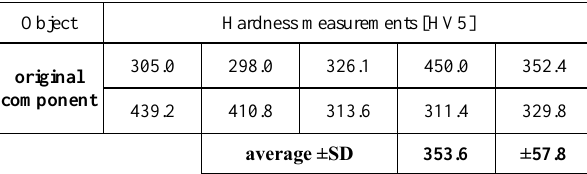
Table 6. Results of HV5 hardness measurements of sleeve A from belts imitating the original Object Hardness measurements [HV5] imitation component A